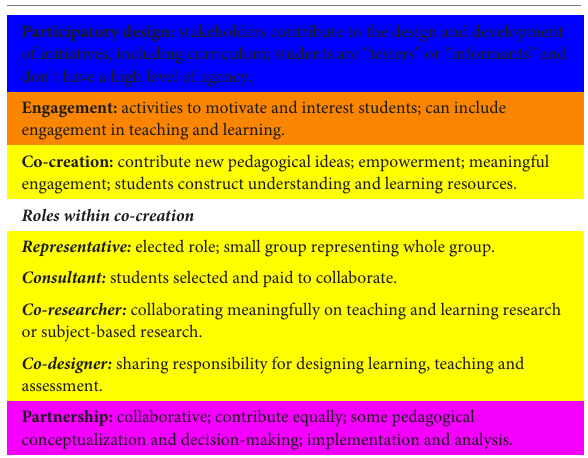
TABLE 1 Bovill’s (2020) terms of inclusion framework and roles within co-creation (adapted from original). Terms of